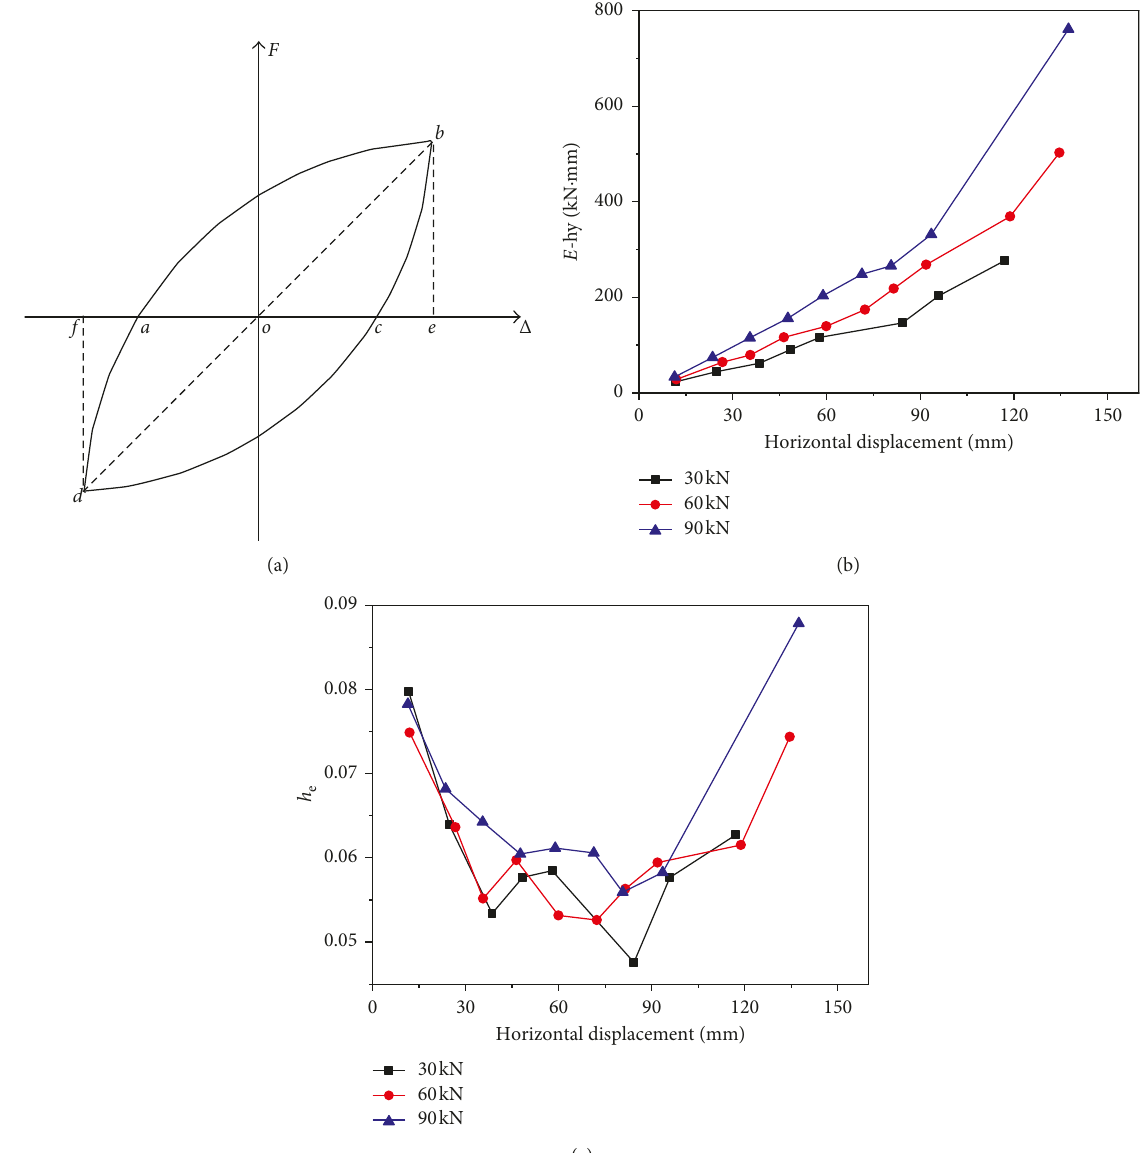
Figure 9: Curves of the energy dissipation. (a) Lateral force-displacement hysteretic loop; (b) curves of the hysteretic energy dissipation ( E -hy); (c) curves of the equivalent viscous damping coefficient ( h e